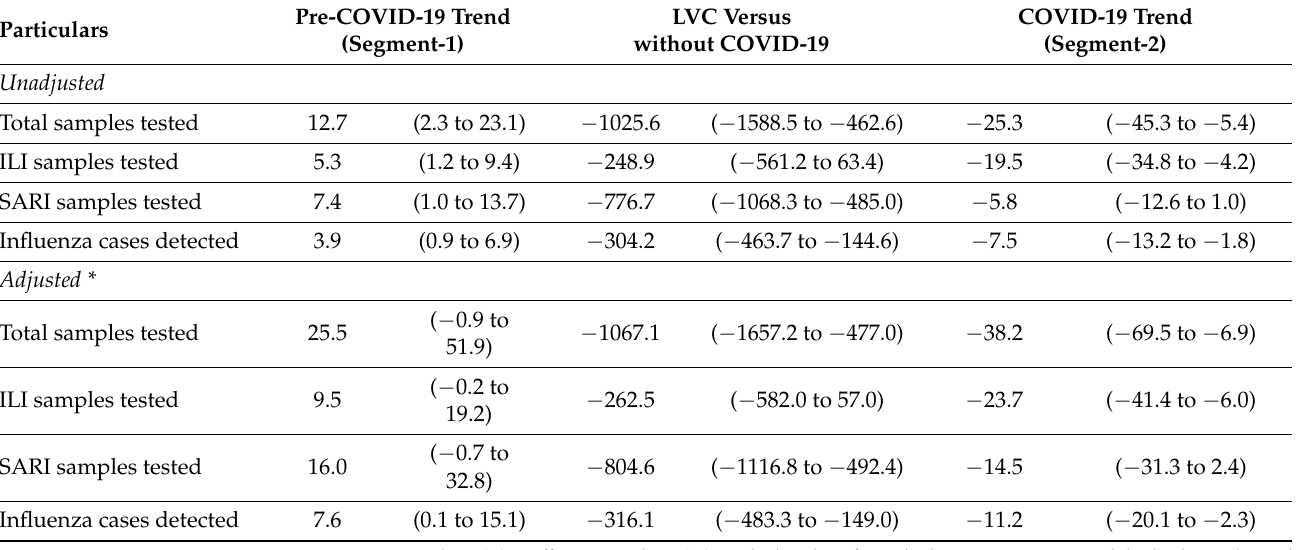
Table 3. Interrupted time series analysis of monthly number of samples tested for influenza